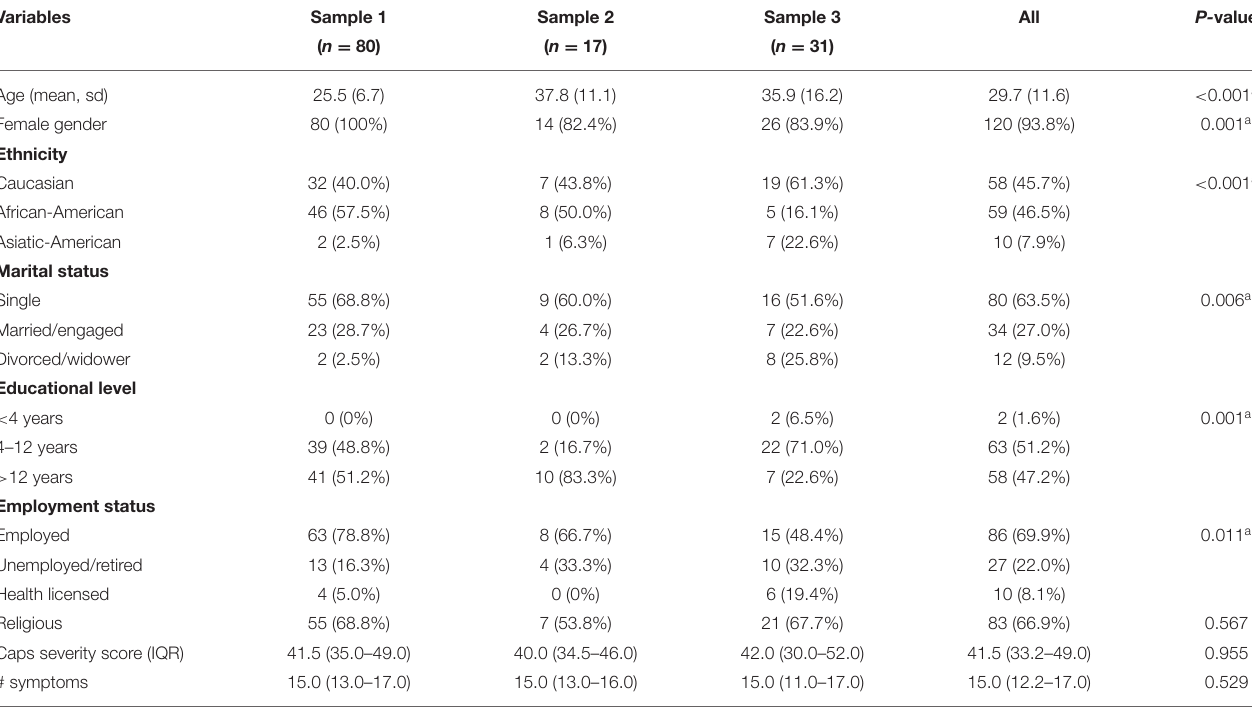
TABLE 1 | Sociodemographic data from three samples ( n =